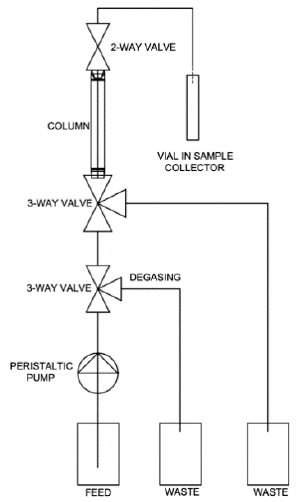
Figure 1. Dynamic sorption layout.